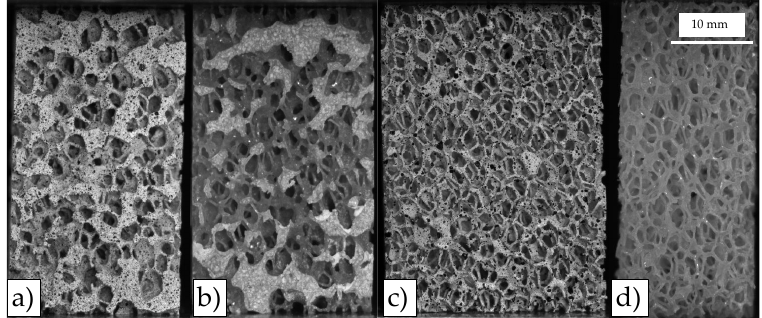
Figure 5. Speckled and non-speckled specimens example: ( a ) HD6 speckled, ( b ) HD8 non-speckled, ( c ) LD6 speckled and ( d ) LD7